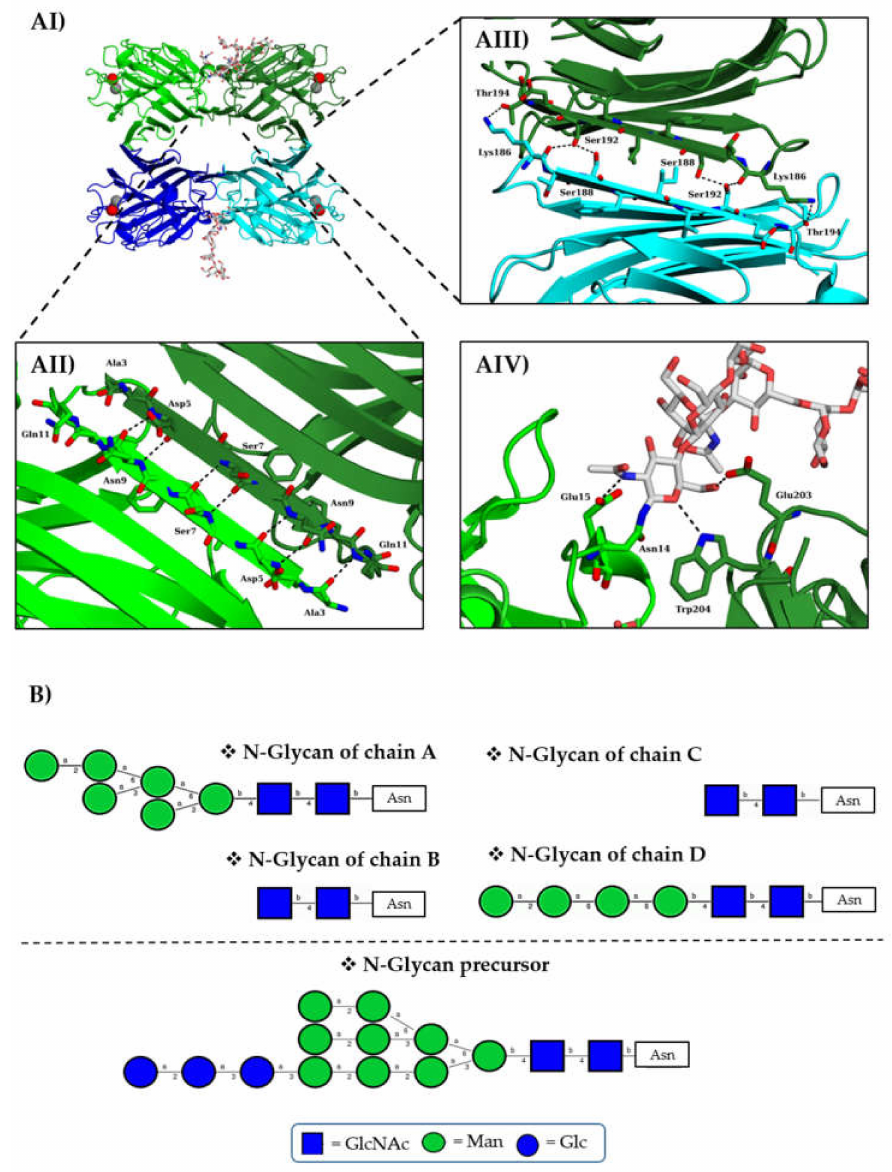
Figure 4. Structure, N-glycosylation, and interface interactions in r TBL-1 tetramer: ( AI ) rTBL-1 tetramer colored by chains with chains A, B, C, and D in light green, dark green, dark blue, and light blue, respectively, with Ca 2 + depicted in red spheres and Mn 2 + depicted in grey spheres. ( AII ) Stabilizing interactions of the interface between A and B chains. ( AIII ) Stabilizing interactions of the interface between B and D chains. ( AIV ) GlcNAc interactions in the interface of two adjacent chains. ( B ) Structure of the N -glycans identified in each monomer of r